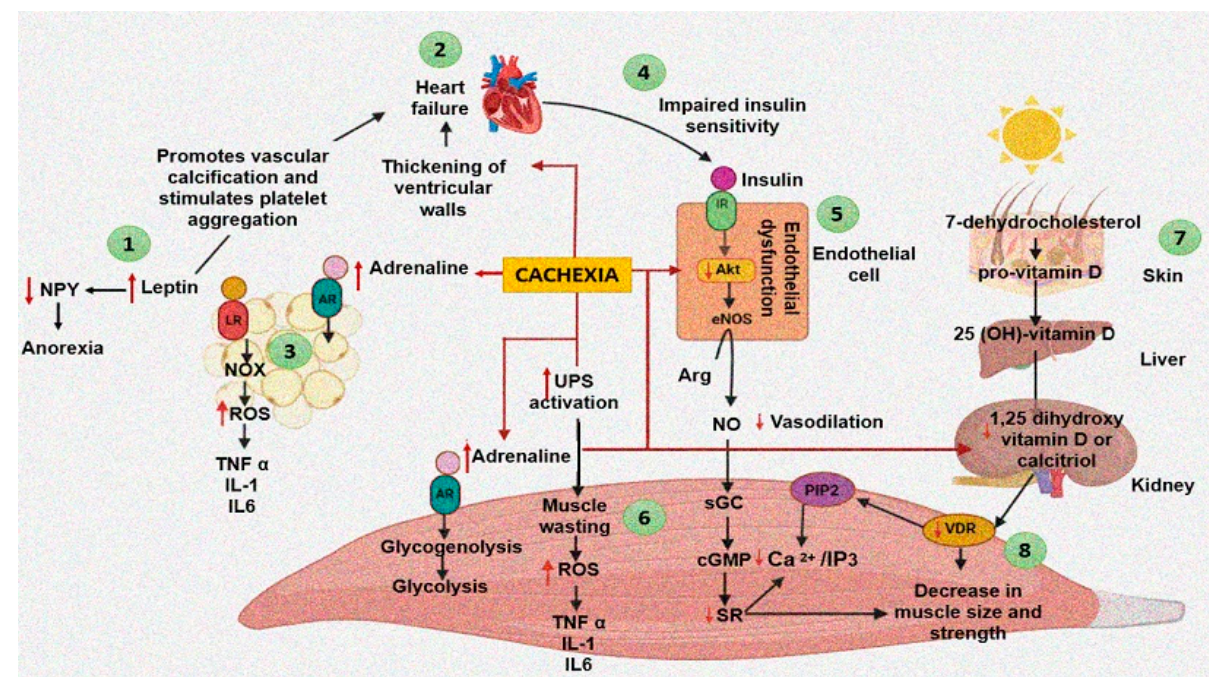
Figure 1. Events and processes generated by cardiac cachexia and heart failure and interrelation between different organs (skeletal muscle, heart, adipose tissue, endothelial cells, kidney, and liver) and their influence on the appearance of cachexia. ( 1 ) Leptin promotes a prothrombotic state. ( 2 ) Heart failure leads to alterations in the synthesis and degradation of cardiac proteins. ( 3 ) Leptin promotes an inflammatory environment. ( 4 ) Impaired insulin sensitivity as a result of heart failure. ( 5 ) The decrease in insulin sensitivity as a consequence of cachexia favors endothelial dysfunction. ( 6 ) Muscle wasting as a result of increased UPS and an inflammatory environment due to cachexia. ( 7 , 8 ) Vitamin D and VDR deficiency affect muscle structure. Abbreviations: Arg = Arginine, AR = Adrenaline receptor, cGMP = Cyclic guanosine monophosphate, eNOS = Endothelial nitric oxide synthase, IL = Interleukin, IR = Insulin receptor, LR = Leptin receptor, NO = Nitric oxide, NOX =